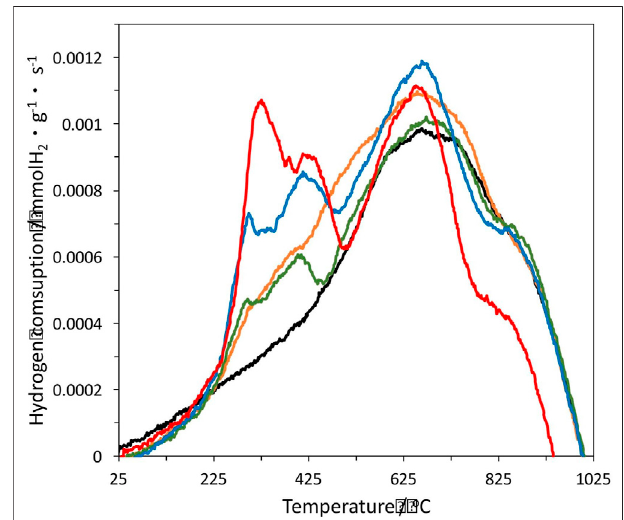
FIGURE 2 | Temperature programmed reduction of the different samples. 1%Pt is in black, 1%Pt-0.25%In in orange, 1%Pt-0.5%In in green, 1%Pt-1%In in blue and 1%Pt-1.5%In in